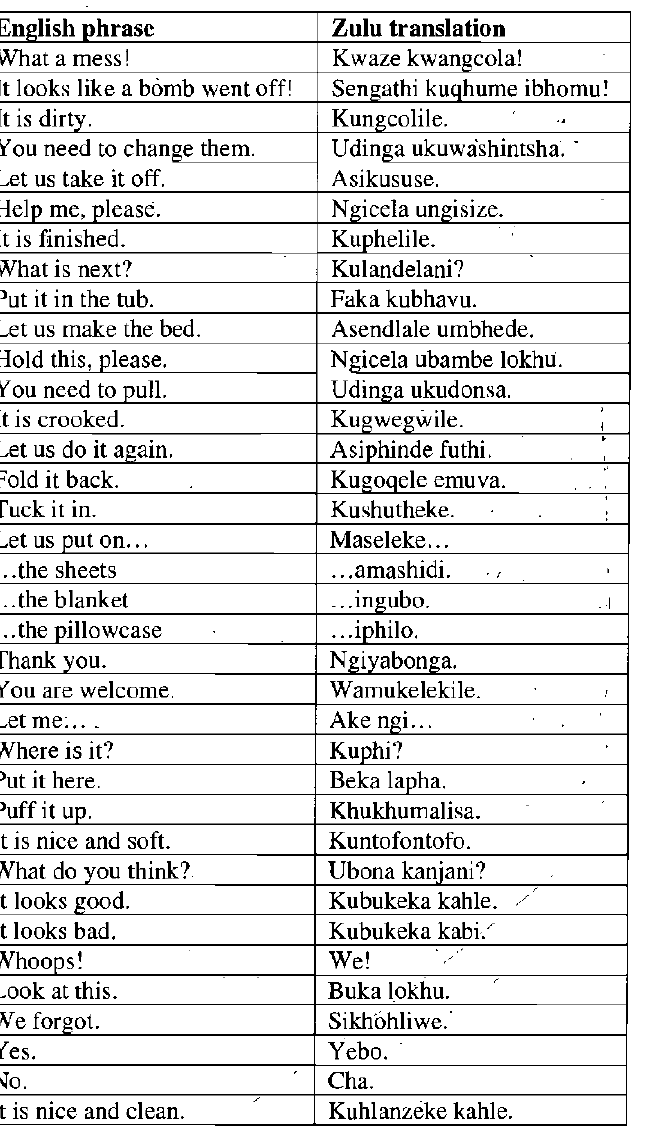
Table 1: Final translations of